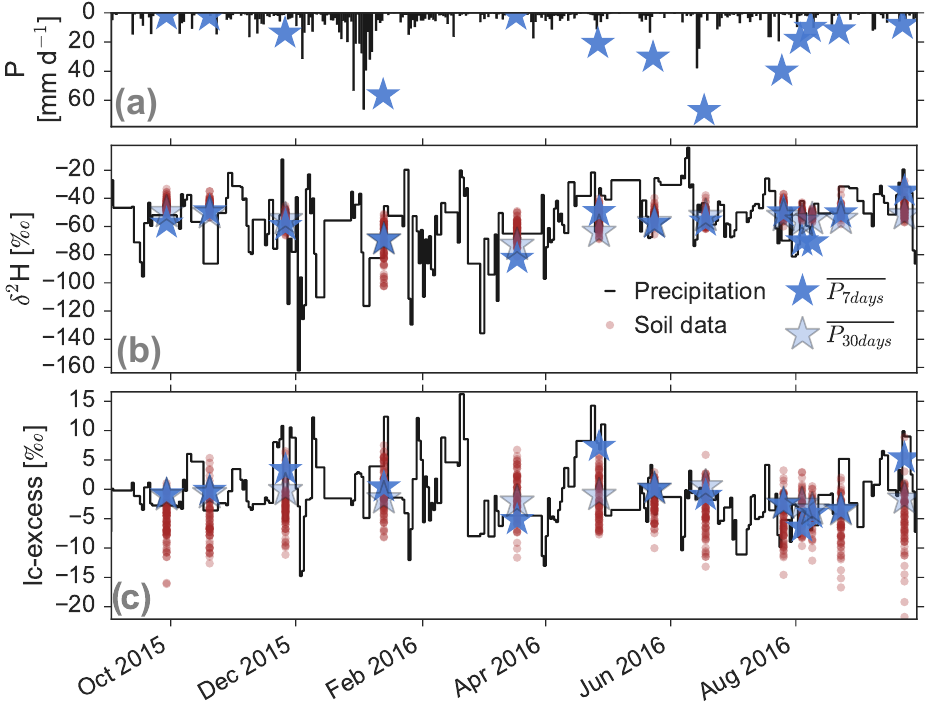
Figure 2. (a) Daily precipitation sums shown in a bar plot and precipitation sums over the 7 days prior to the soil sampling P 7 as a blue star. (b) Dynamics of the δ 2 H and (c) lc-excess in the precipitation input (black line) and soil waters (half transparent brown dots). Stars indicate values as weighted averages over 7 days (P 7 , blue) and 30 days (P 30 , light blue) before the day of soil sampling.